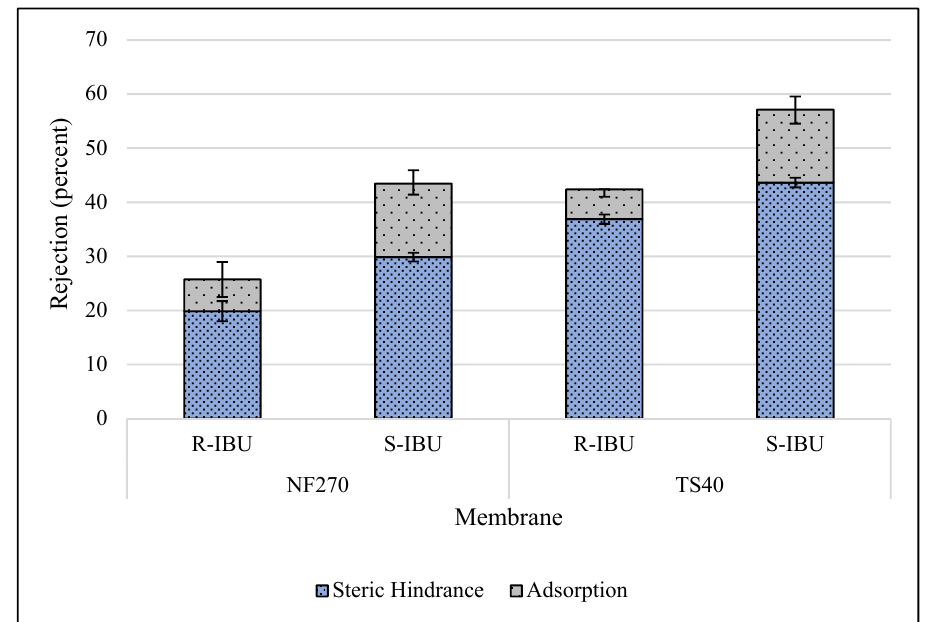
Figure 5. Rejection of R- and S-IBU at a feed water pH of 4.0 units (initial IBU concentration 400 µg/L, water flux 42.4 L/m 2 h, temperature 20 ± 1 °C). Error bars represent minimum and maximum values from triplicate analysis.